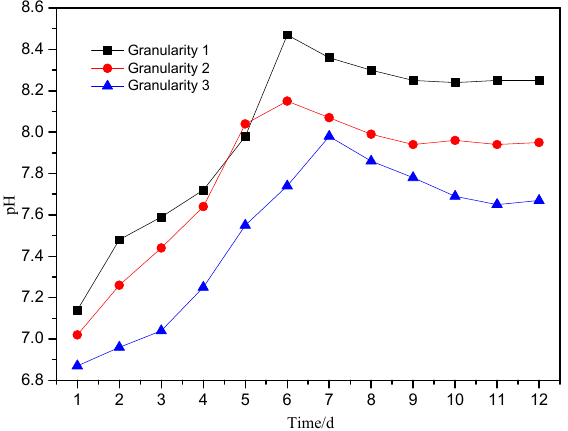
ff erent particle size of